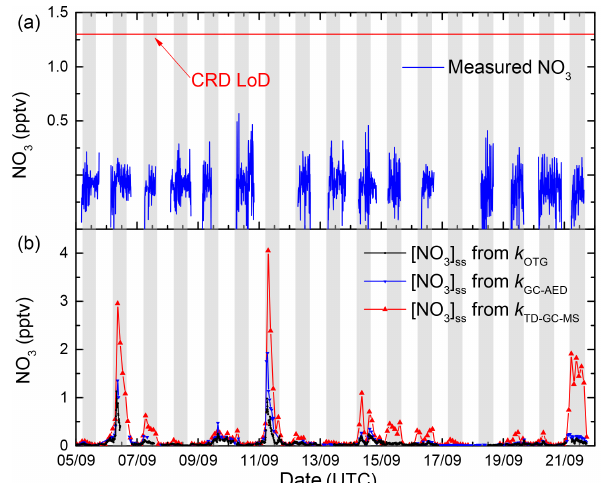
Figure 10. Stationary state NO 3 mixing ratios calculated from the production term ( k 1 [NO 2 ][O 3 ]) and using either k OTG + k 2 [NO] + J NO ( b , black line), k GC-MS + k 2 [NO] + J NO 3 3 ( b , red line), or k GC-MS + k 2 [NO] + J NO ( b , blue line) as loss 3 terms. For comparison, the measured NO 3 mixing ratios are also plotted ( a , blue line) as well as the 1.3pptv limit of detection (hori- zontal red